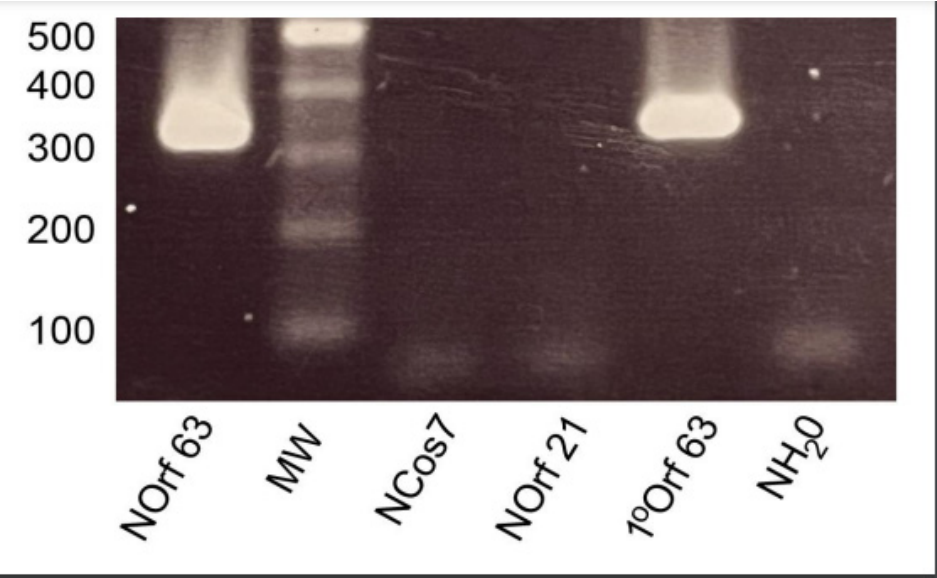
Figure 2. Gel analysis of nested PCR. Nested PCR of ORF 63. Primary PCR amplifies a 386 bp product which yields a 326 bp fragment following a secondary PCR nested run. Nested ORF21, nested Cos7 and nested water controls were negative.